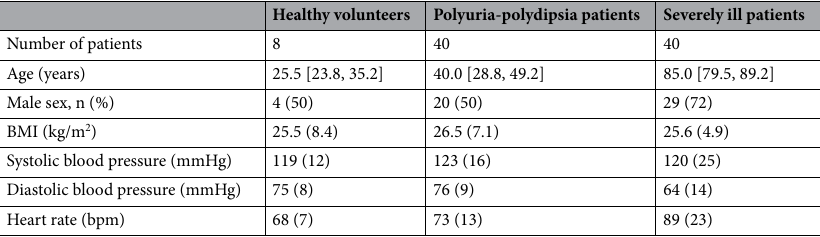
Table 1. Baseline Characteristics of all three cohorts. Continuous variables are expressed as median [Interquartile range], categorical variables as number and percentage. BMI body mass index, n number, bpm beats per minute, mmHg millimeter